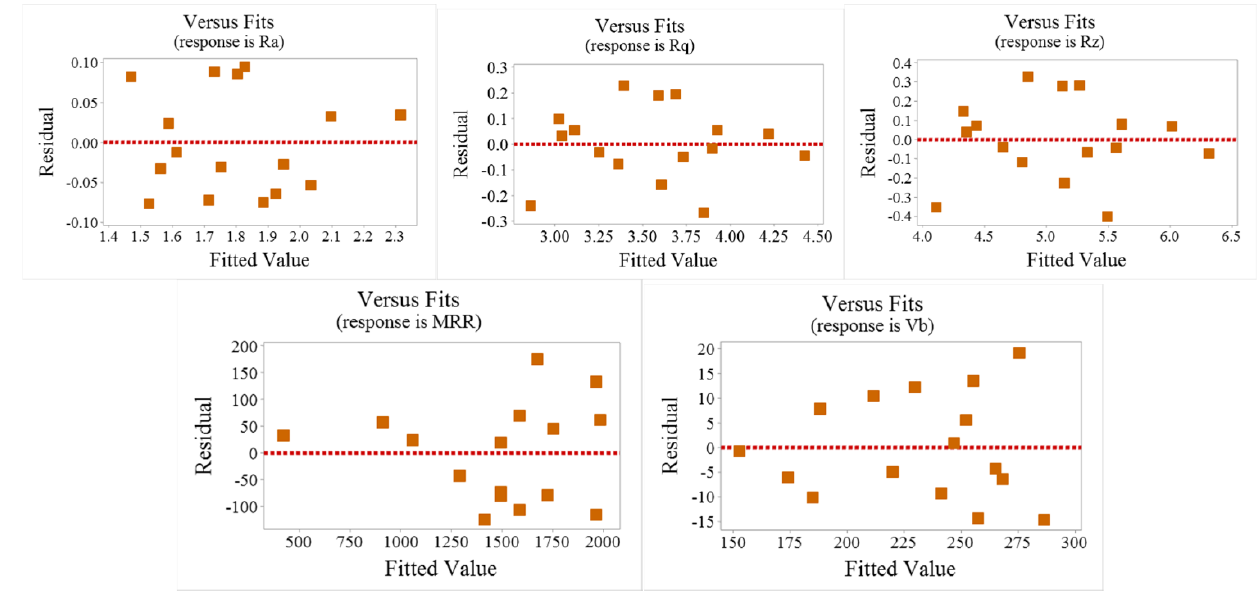
Figure 7. Versus fits plots of responses.